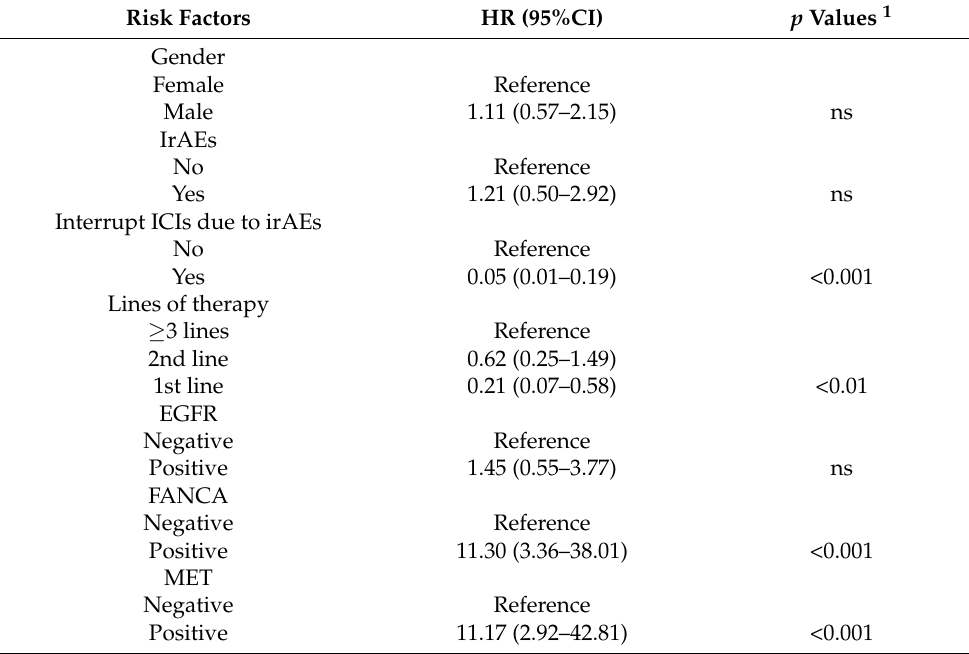
Table 6. Multivariate analysis for OS ( n =